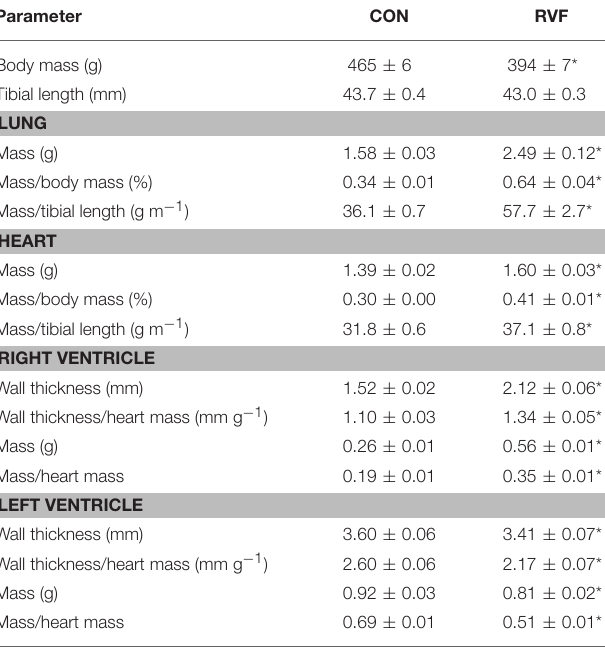
TABLE 1 | Morphometric characteristics of Control and RVF rats at